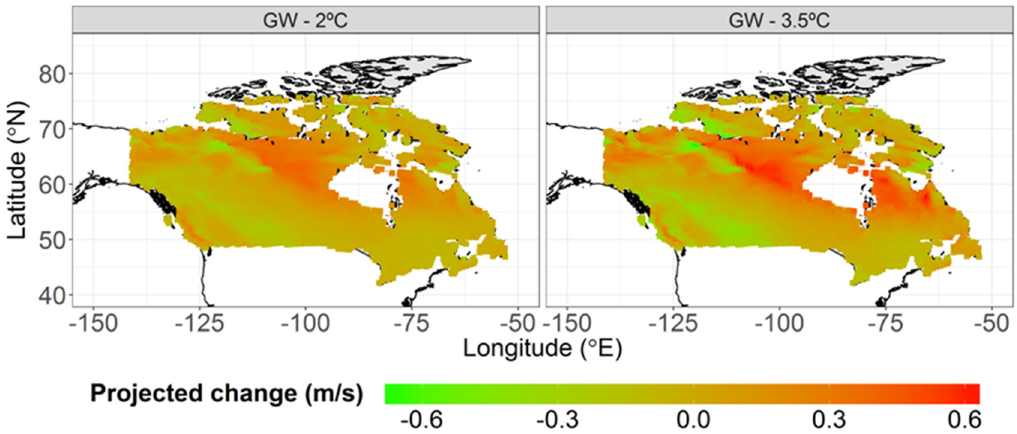
Figure 8. Projected changes in average wind speeds across Canada under globally averaged warming of 2°C and 3.5.